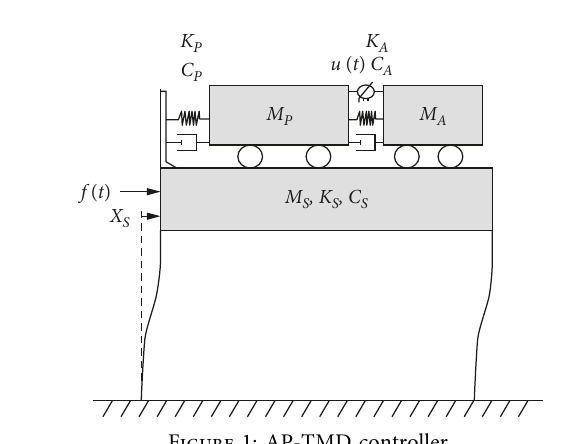
Figure 1: AP-TMD controller.